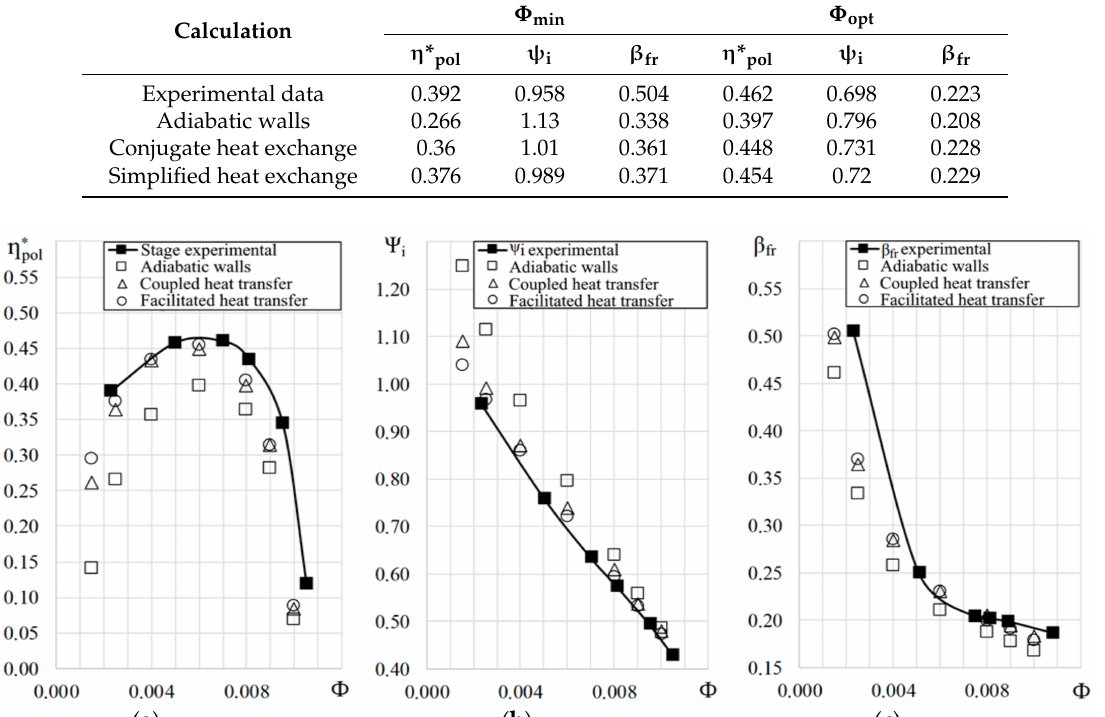
Figure 2. Gas-dynamic characteristics of the SVD-1 stage, taking into consideration the surfaces’ heat exchange as compared with the experimental data. ( a ) Polytropic e ffi ciency η * p ( b ) Internal pressure coe ffi cient ψ i ( c ) Disk friction coe ffi cient β fr